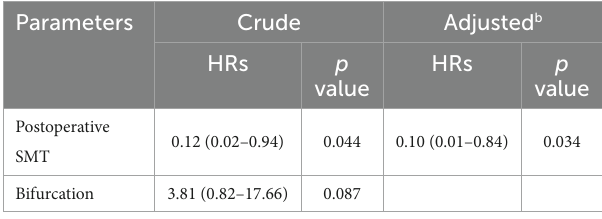
TABLE 3 Multivariate Cox analysis a for risk factors related to